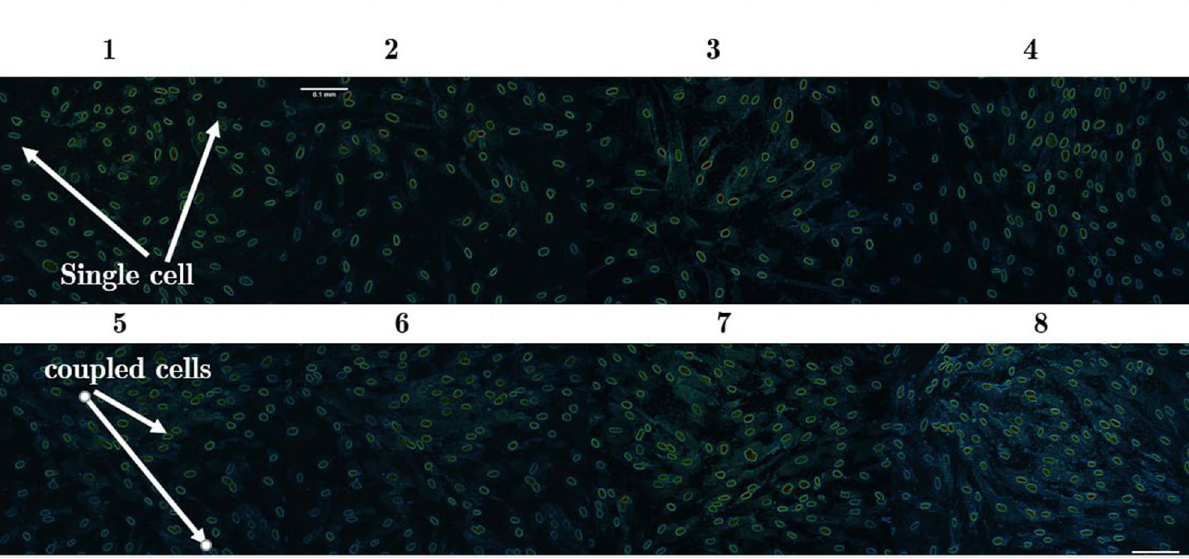
Figure 9. Focal adhesion images for: (1) before treatment and before FA formation, (2) cells treated with Argon (plasma-off) after the formation of FA, and from 3 to 8 the cells were directly exposed to plasma (power = 20 W) for different exposure times: (3) t = 30 s, (4) t = 50 s, (5) t = 70 s, (6) t = 90 s, (7) t = 100 s, (8) t = 120 s. As can be seen in 3–8, more focal points are formed. Increase in FA points depends on the exposure time.